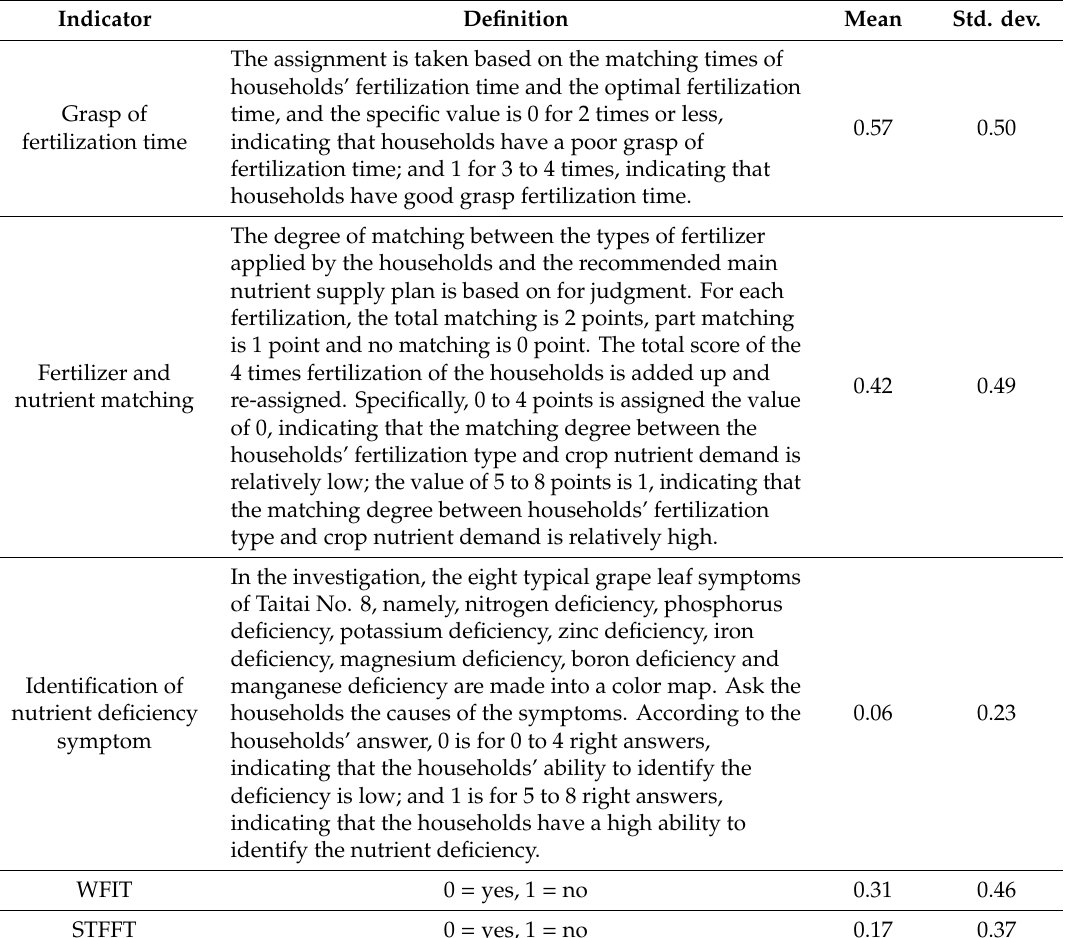
Table 5. Measurements and descriptions of households’ fertilization knowledge and